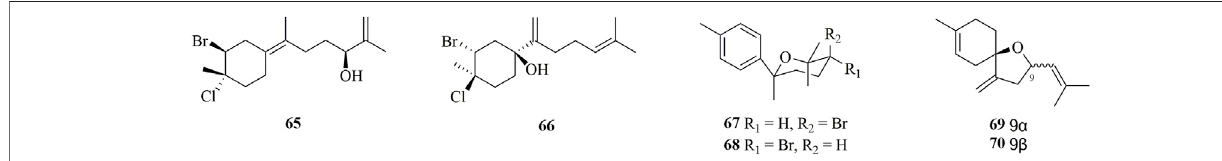
FIGURE 5 | Bisabolanes characterized from marine algae ( 65 – 70 ).